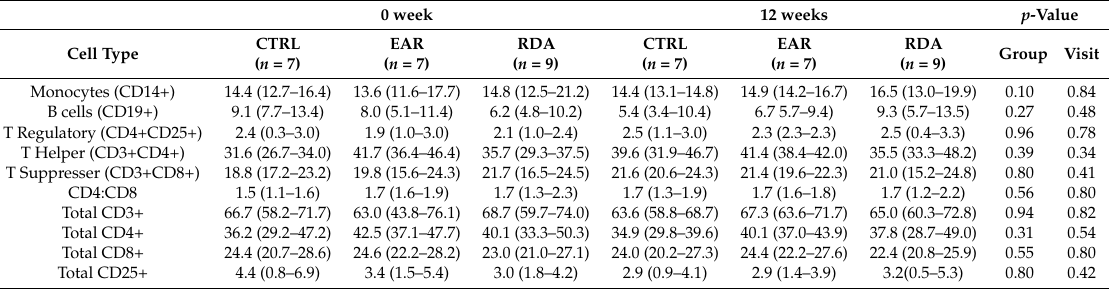
Table 4. Mononuclear cell phenotypes in 6–8 years old subset of 12 weeks trial.